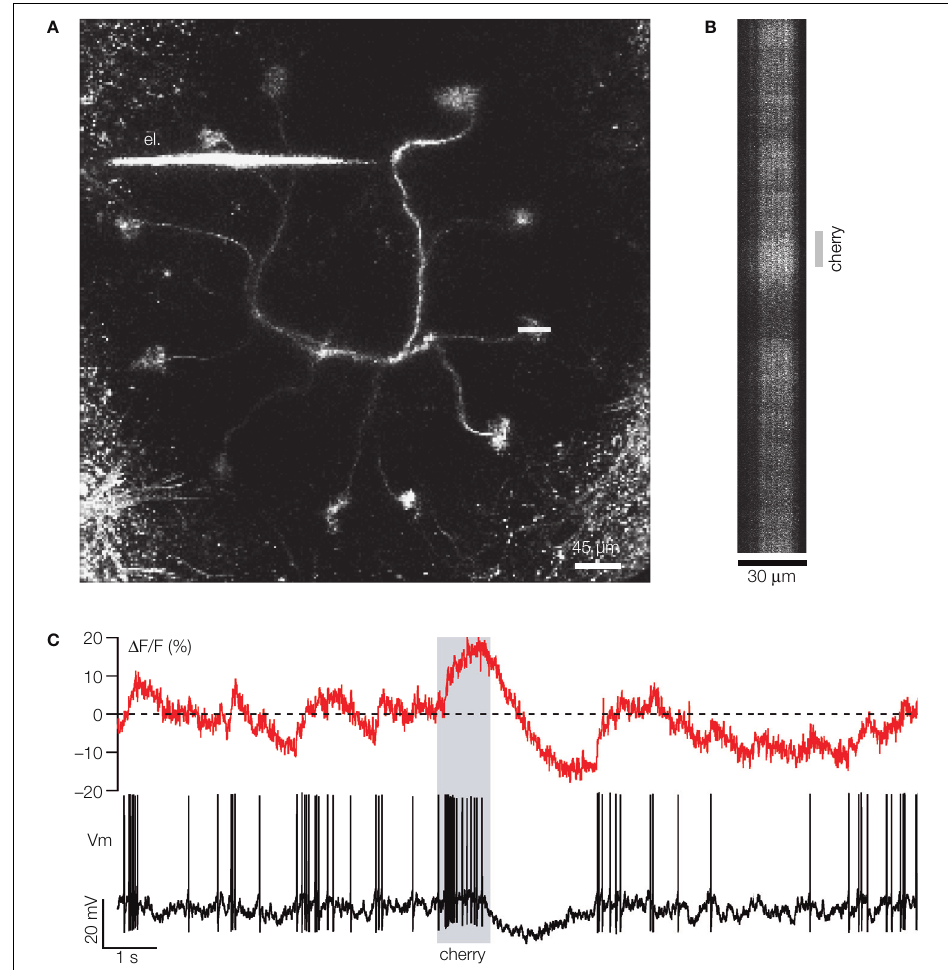
Figure 1 | In vivo simultaneous dendritic voltage recordings and two-photon calcium imaging in the locust projection neuron. (A) A frontal view of a PN labeled from a secondary dendrite via a microelectrode (el.) fi lled with the fl uorescent calcium indicator OGB-1. Eleven of the PN’s 12 glomerular tufts can be seen, forming a circle in one plane. The soma and axon of the neuron are respectively above and below the dendritic plane (not included in this view). Shortly after dendritic impalement, one of the several tufts of the PN is selected for fl uorescence imaging (horizontal white line). Calcium signal is then acquired simultaneously with voltage across the glomerular tuft using a line scan (typically 30 μ m × 24 s). (B) Example of a single 16 s-long line-scan trial during odor presentation [different PN from that in (A) ]. (C) Glomerular calcium Δ F/F integrated along the scanned line [500 Hz sampling, PN in (B) ] and simultaneous intracellular (15 kHz sampling). Stippled line: average baseline fl uorescence before odor presentation membrane potential V m to the animal. Note the complex modulations of the calcium signal and their relationship to